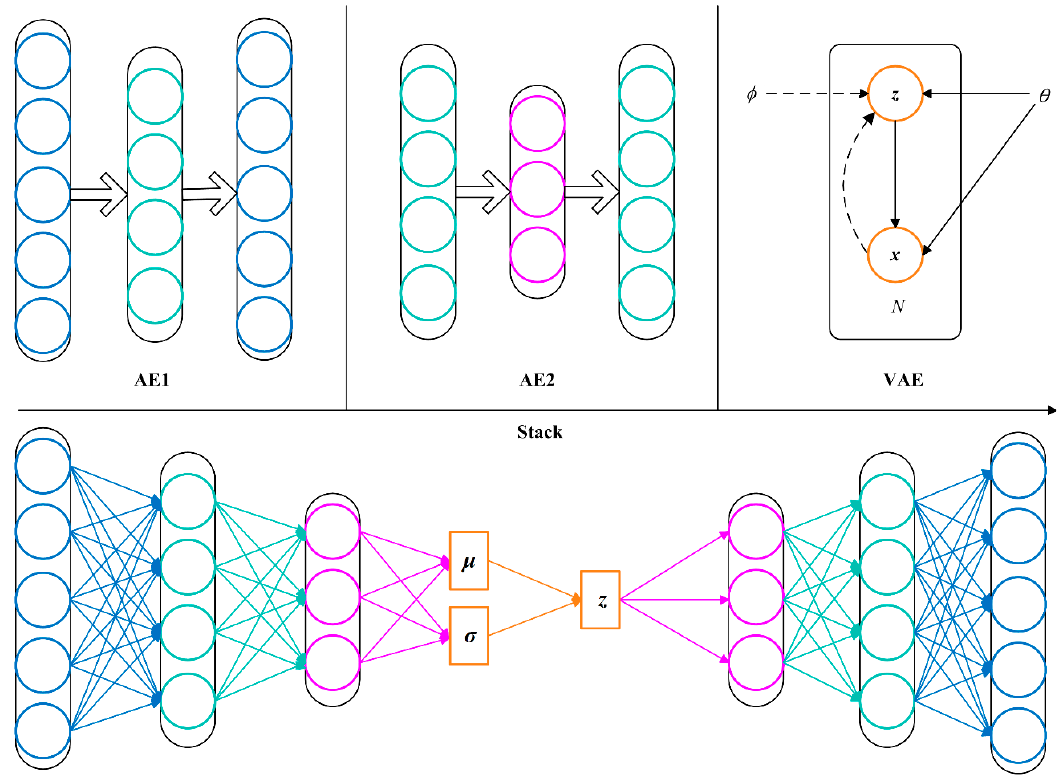
Figure 3. The construction process of variational stacked autoencoder (VSAE) model.